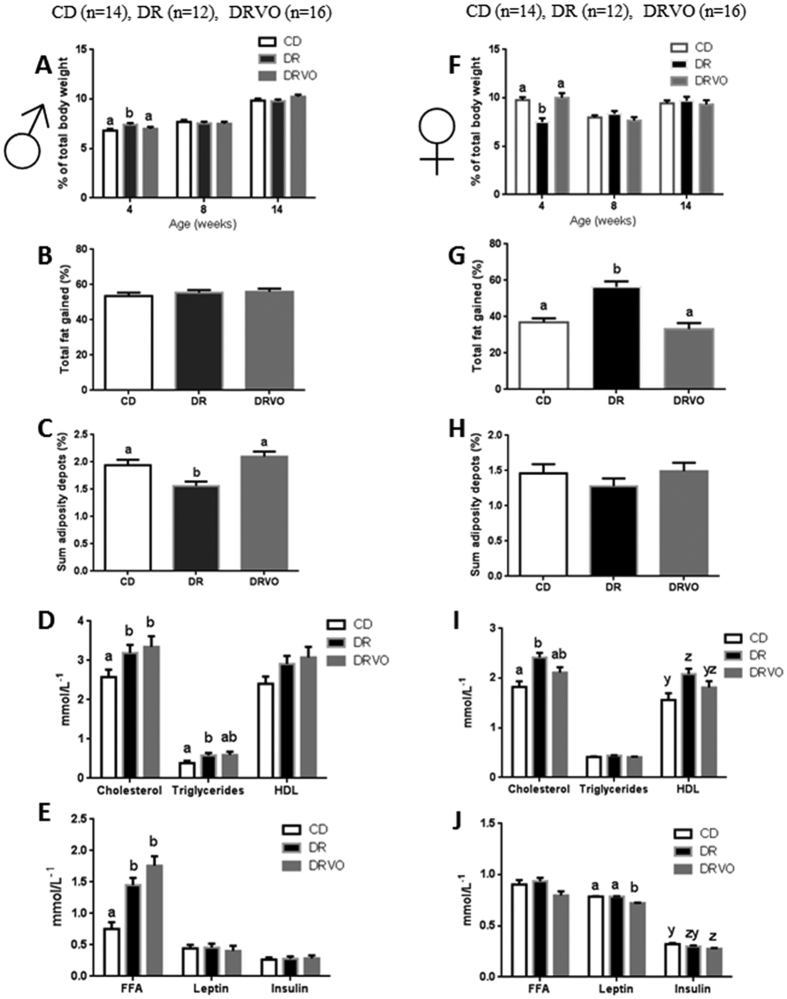
Vitamin and antioxidant supplementation of under nourished fathers restores male and female offspring adiposity and circulating lipids, insulin and leptin in female offspring.(A) Total adiposity as a percentage of body weight in male offspring as measured by DEXA at 4, 8 and 14 weeks of age. (B) Total adiposity gained (4 to 14 weeks) in male offspring as a percentage of fat mass at 14 weeks as determined by DEXA. (C) Sum of adipose depots (omental, gonadal, renal and dorsal) as a percentage of body weight at 15 weeks for male offspring. (D) Fasted serum lipids in male offspring at 15 weeks. (E) Fasted free fatty acids, leptin and insulin levels in male offspring at 15 weeks. (F) Total adiposity as a percentage of body weight in female offspring as measured by DEXA at 4, 8 and 14 weeks. (G) Total adiposity gained (4 to 14 weeks) in female offspring as a percentage of fat mass at 14 weeks as determined by DEXA. (H) Sum of adipose depots (omental, gonadal, renal and dorsal) as a percentage of body weight at 15 weeks for female offspring. (I) Fasted serum lipids in female offspring at 15 weeks. (J) Fasted free fatty acids, leptin and insulin levels in female offspring at 15 weeks. Data represents 14 females and 14 males from 7 litters generated from 6 founders for CD group, 12 females and 12 males from 6 litters generated from 6 founders for DR group, and 16 females and 16 males from 8 litters generated from 8 founders for the DRVO group. Statistical significance was determined by repeated measures ANOVA, with founder ID added as a random factor for adiposity data and a general linear mixed model with founder ID added as a random factor for all other measures to adjust outcomes for offspring generated from the same founder. Data is expressed as mean ± SEM. Different letters denote significance at P < 0.05.